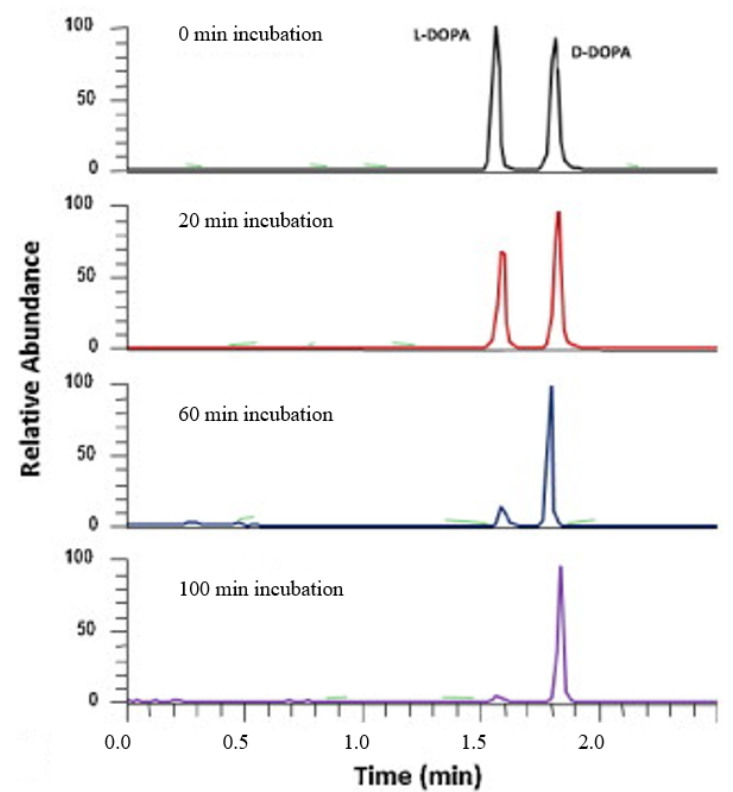
Figure 10. Electropherograms obtained from studying DOPA metabolism in SH-SY5Y neuronal cells. TICs of m / z 198 from incubation solution injected at different times, and a peak height of L -DOPA decreases gradually as incubation time increases while that of co-existing D-DOPA remains unchanged. Both Figure and Figure caption is adapted from Li et al. [38], with permission from Elsevier.